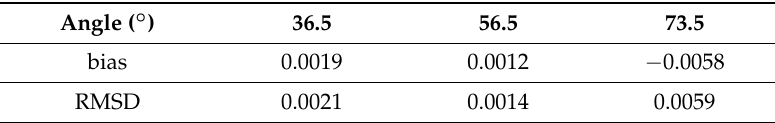
Table 1. The bias and RMSD values of the simulated sea surface emissivity values, using the average of the Wu and Smith and Masuda refractive